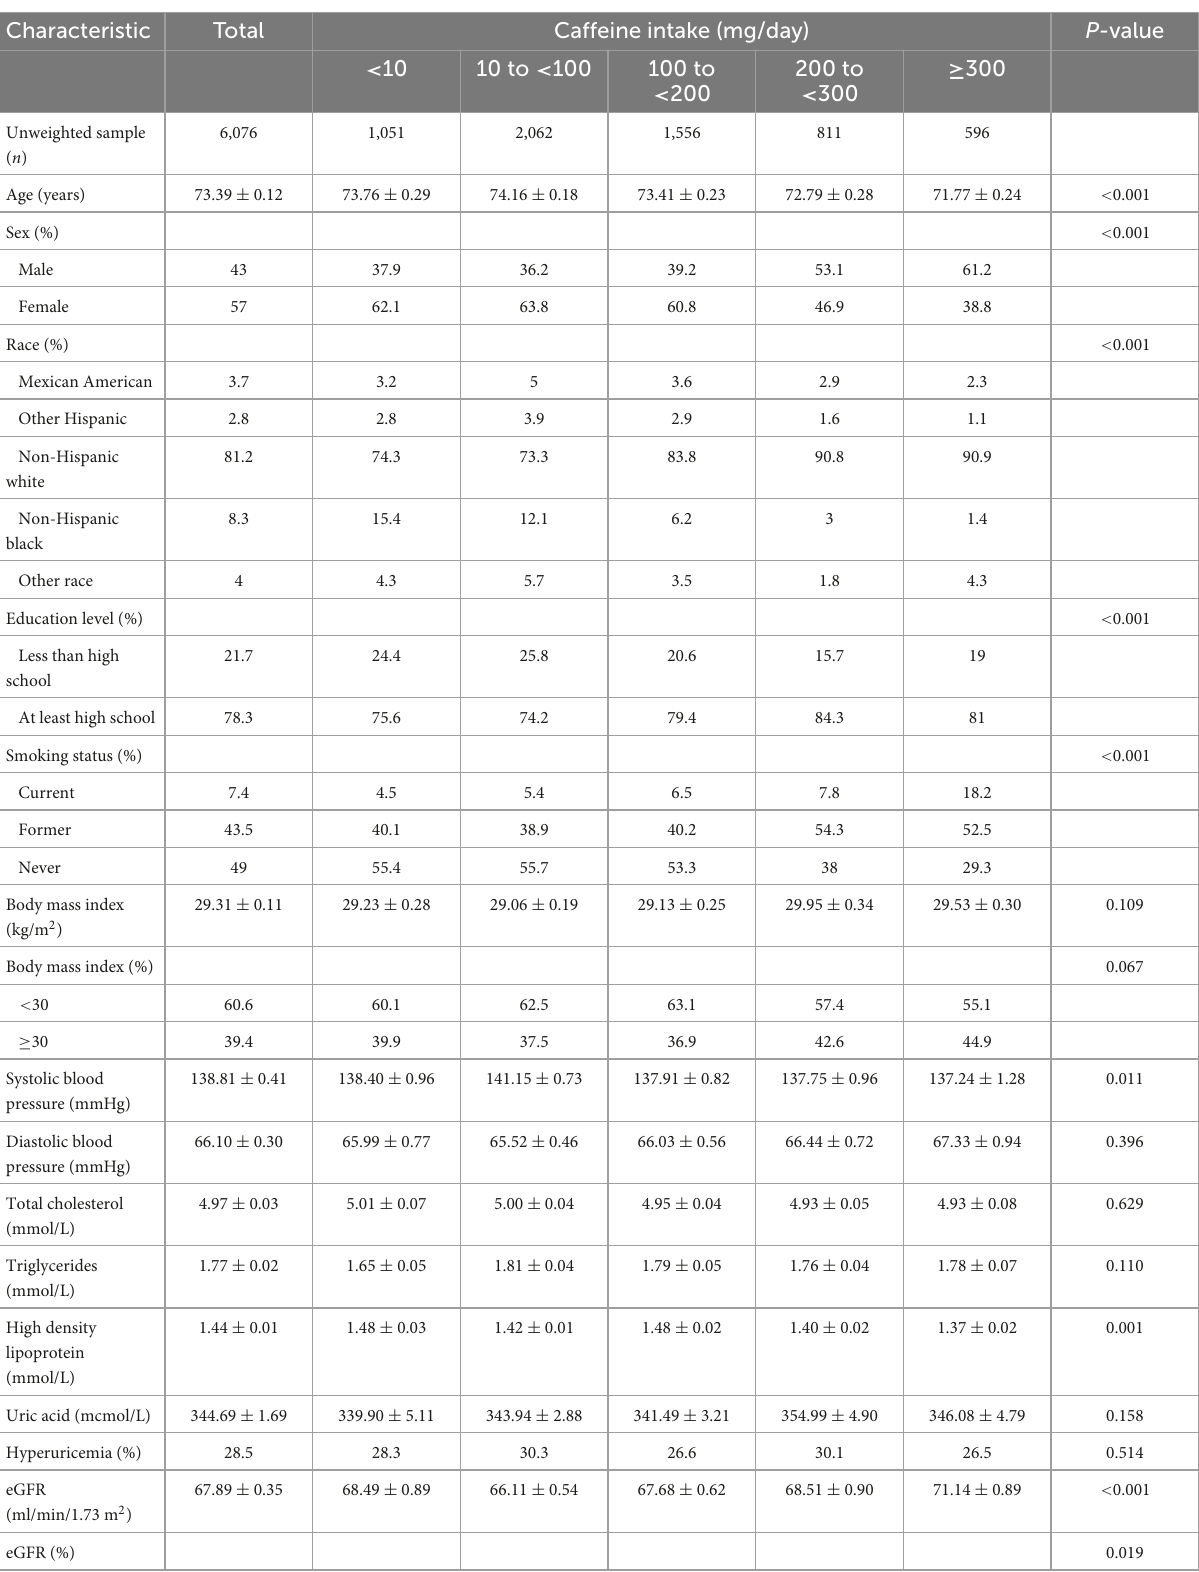
TABLE 1 Participants’ baseline demographic and clinical